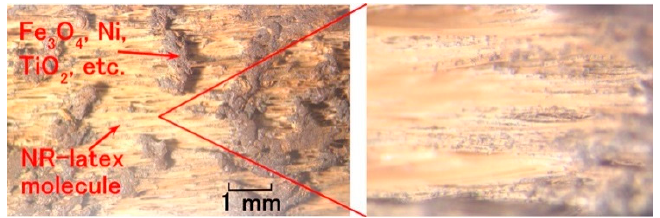
Figure 10. Photographs of surface of elongated MCF rubber electrolytically polymerized with Ni, MF, NR-latex and TiO 2 before addition of dye and electrolyte at 0.8 of extension strain.